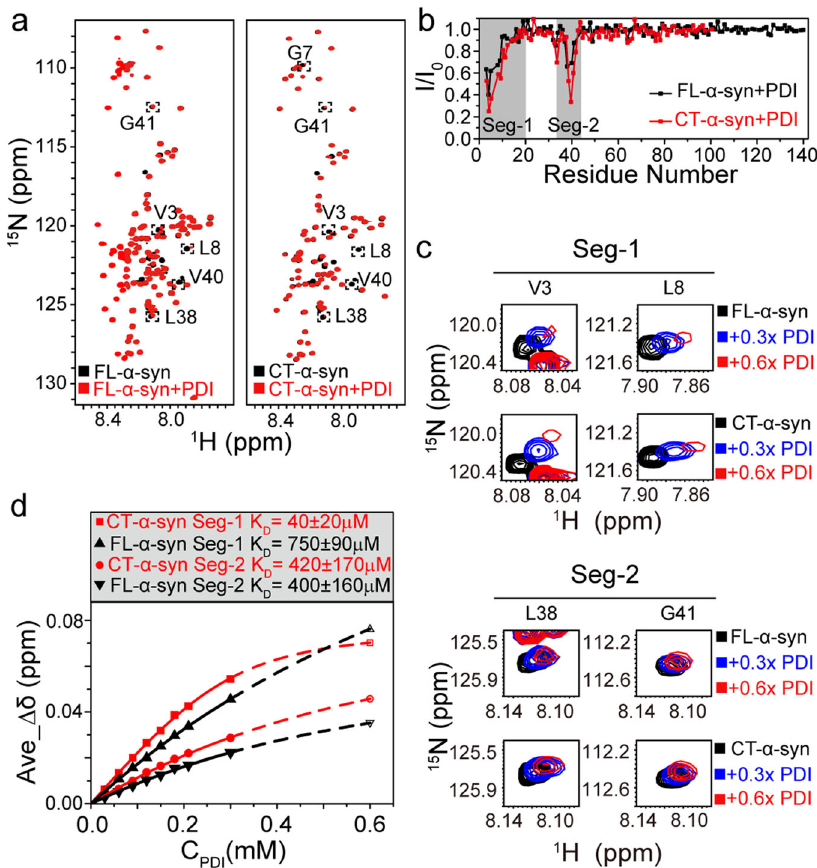
Fig. 2 Stronger interaction of CT- α -syn with PDI. a Overlay of 1 H- 15 N HSQC spectra of 0.3 mM 15 N-enriched FL- and CT- α -syn in the absence (black) and presence (red) of 0.15 mM PDI. Perturbed residues are surrounded by a dotted box. b Residue-resolved signal attenuation (I/I 0 ) of 0.3 mM FL- (black circles) and CT- α -syn (red circles) upon adding 0.15 mM PDI. Values <1.0 indicate interactions. Binding regions are colored gray. c Representative 1 H- 15 N HSQC cross-peaks within segments 1 and 2 of 0.3 mM FL- and CT- α -syn titrated with PDI. d Average CSPs of distinguishable residues within segment 1 (V3, M5, G7, L8, S9, K12, V15, A17, A18, A19, and E20) and 2 (T33, V37, L38, V40, G41, and T44) of FL- and CT- α -syn as a function of the PDI concentration. K D values from curve fi tting are shown. CSP values of FL- and CT- α -syn at 0.6 mM PDI were predicted by fi tting the curve due to signal attenuation from segments 1 and 2 at higher (>0.3mM) PDI concentration.